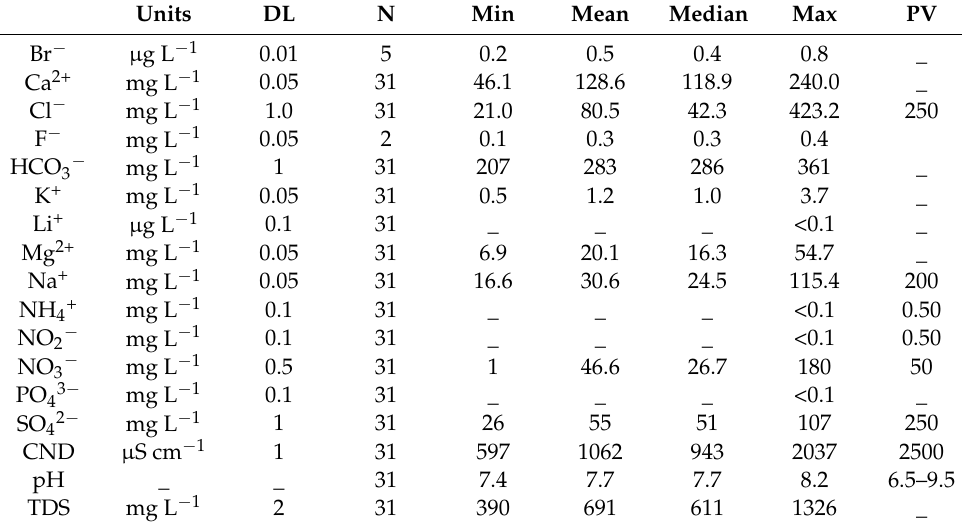
Table 3. Water quality parameters determined in groundwater samples collected from wells located in the study area (DL: Detection Limit; CND: Electrical Conductivity; PV: Parametric Value [45]).